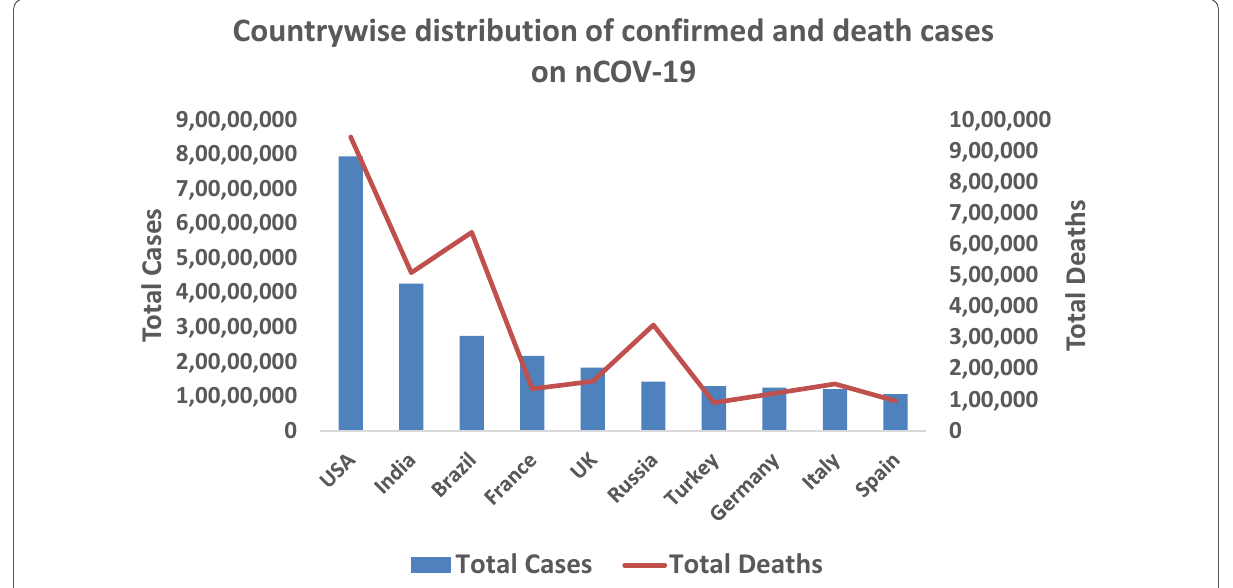
Fig. 6 Number of confirmed and death cases of countries most affected by COVID-19 as of February 15,